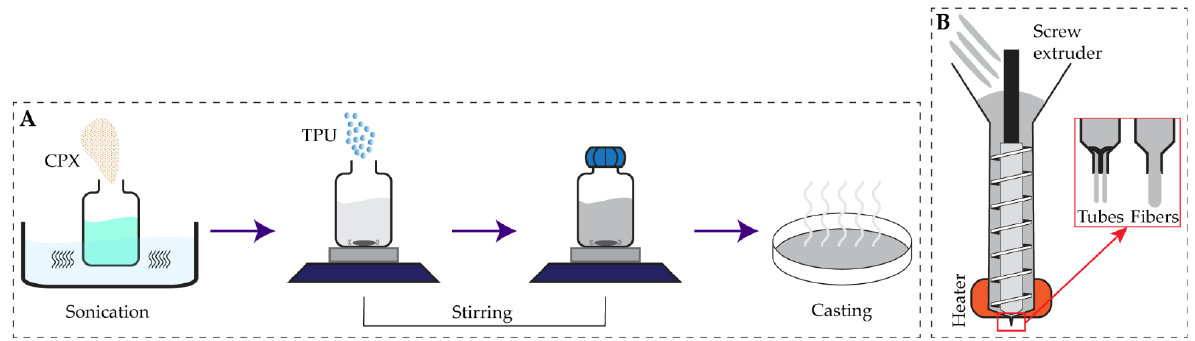
Figure 1. Solvent casting approach used to produce TPU and TPU-CPX films ( A ), hot melt extrusion process using a mini single screw extruder to produce fibers and tubes for material characterization and further in vitro and in vivo testing ( B ).